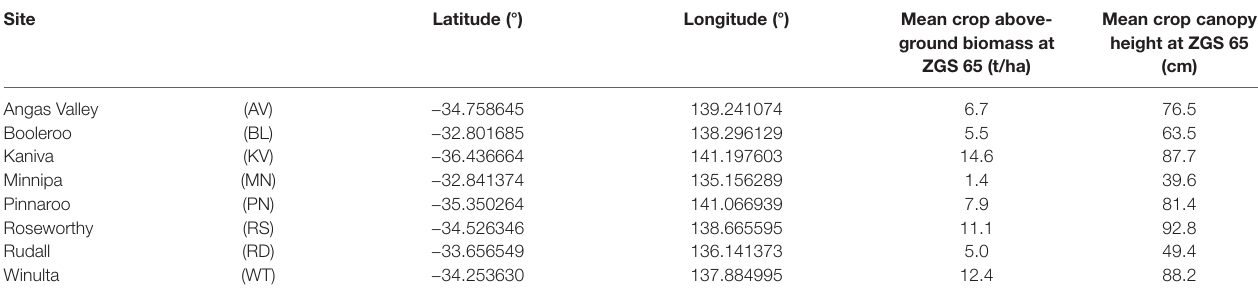
TABLE 1 | Location and details of the eight field trial sites present in the current study. Latitude and longitude are presented in the WGS84 datum.